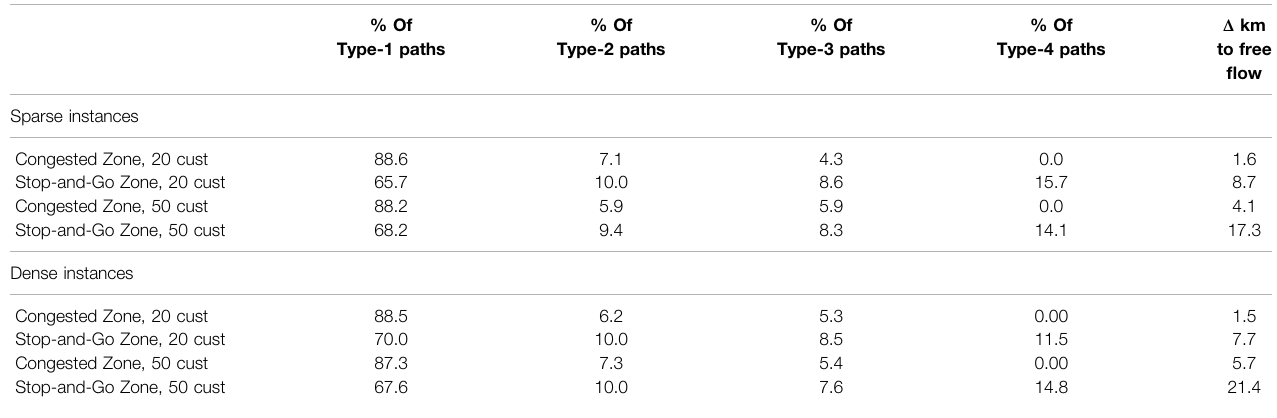
TABLE 2 | Distribution of selected paths to in-zone